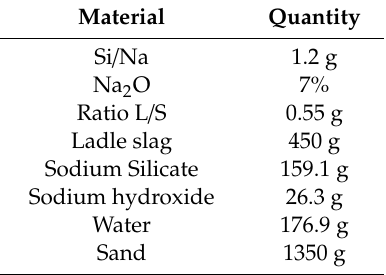
Table 4. Dosage of mortars